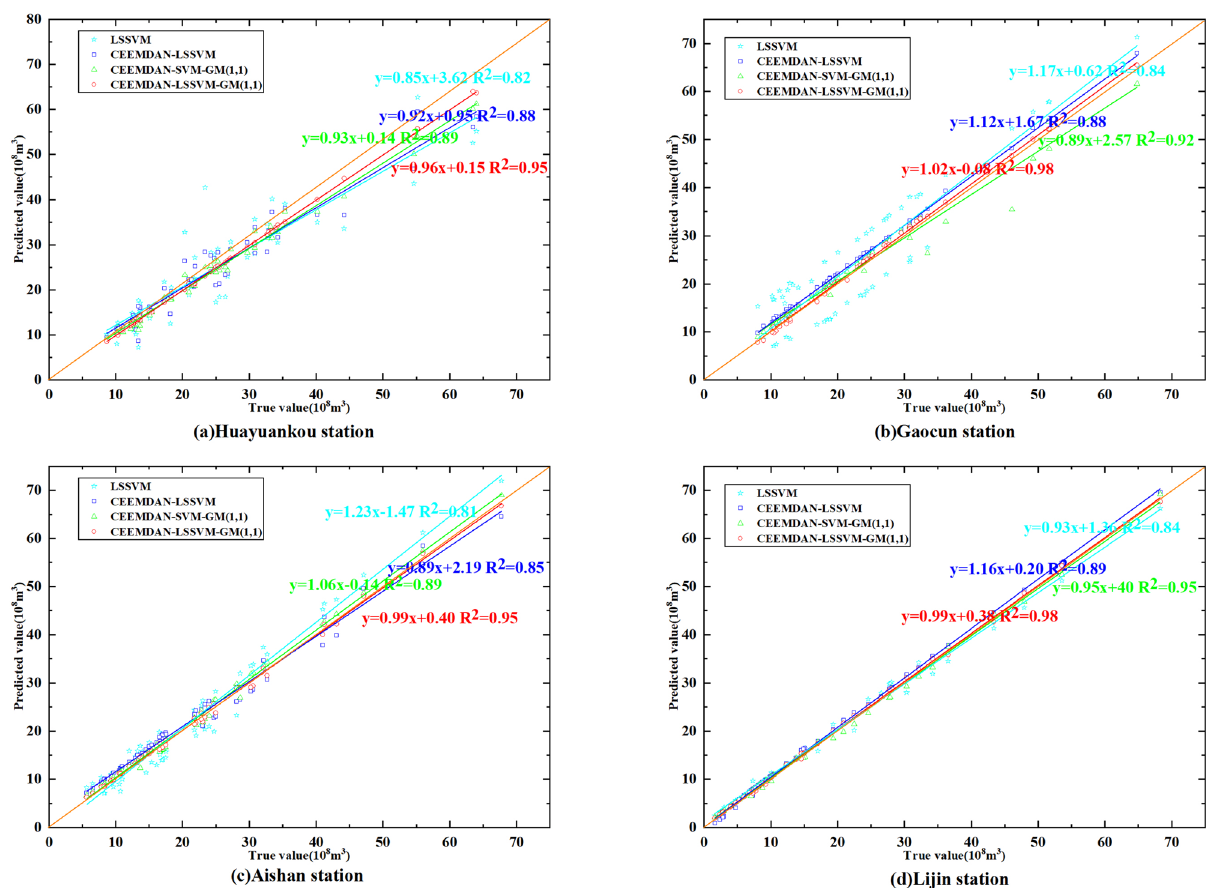
Figure 11. Scatter chart of four model prediction